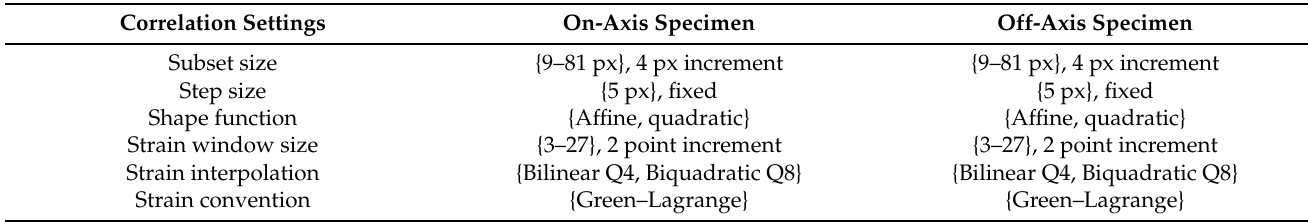
Table 1. Different combinations of DIC parameters set used on the parametric analysis.